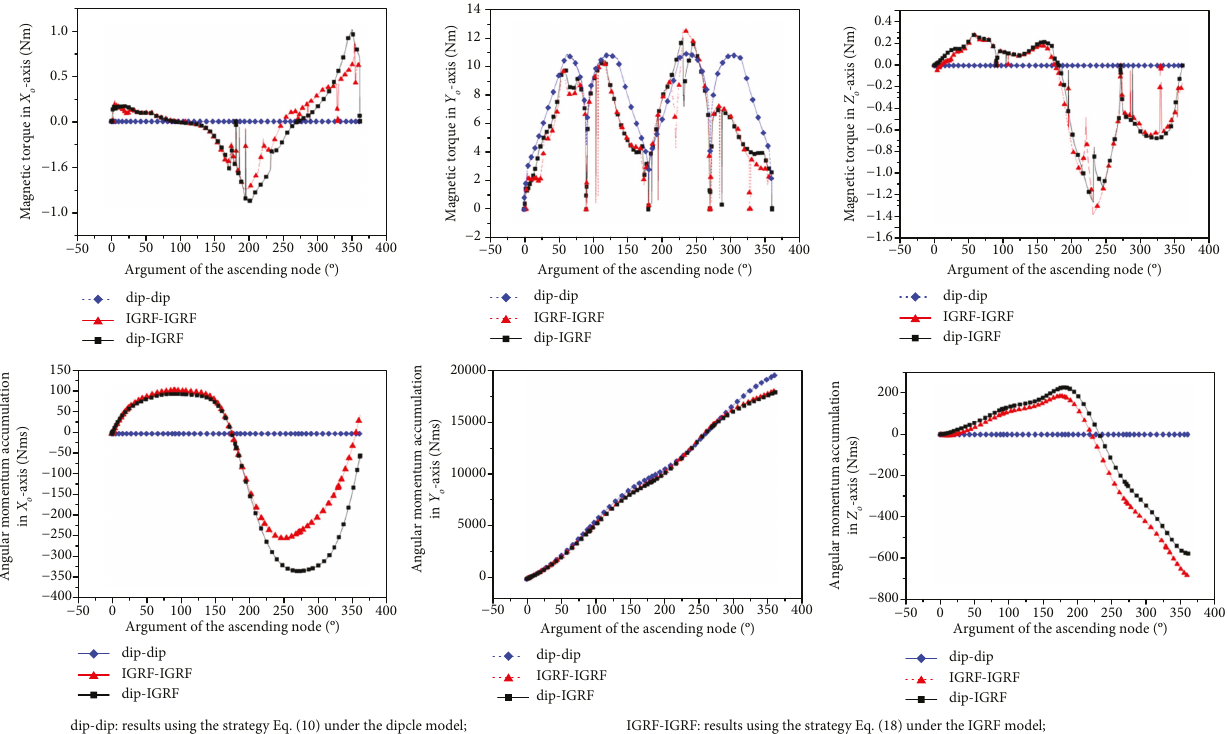
dip-dip: results using the strategy Eq. (10) under the dipcle model; dip-IGRF: results using the strategy Eq. (10) under the IGRF model Figure 5: Magnetic torque and angular momentum accumulation (orbital coordinates) in the circular orbit (950km) under equations (10) and (18) (example 1).